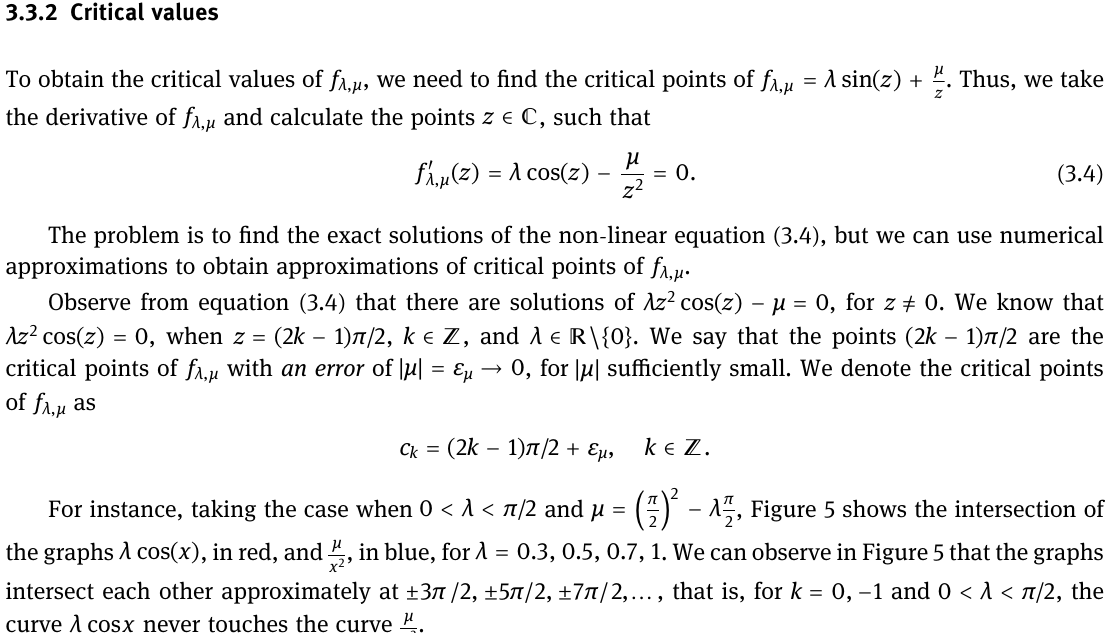
in blue for λ 0.3, 0.5, 0.7, 1 = and μ λ − π π x 2